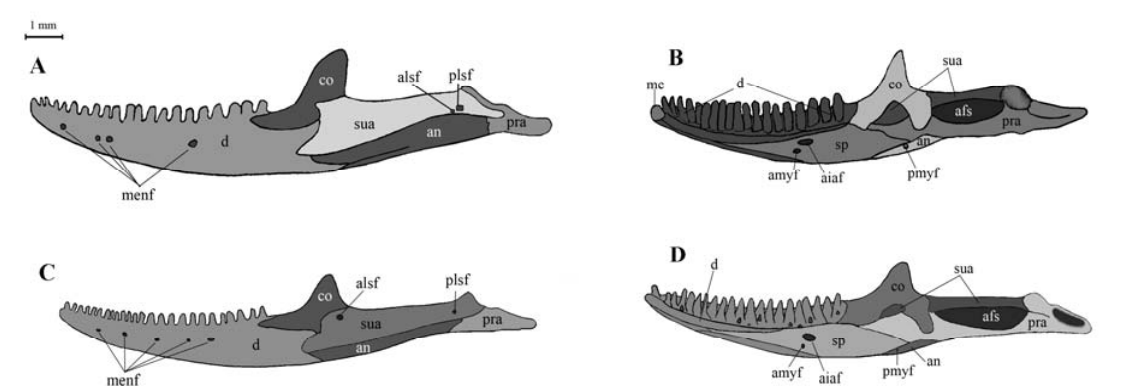
F IGURE 3. Right lower jaw ramus in lateral (A) and medial (B) views in Eremias persica and in Mesalina watsonana, lateral (C) and medial (D) views. Abbreviations: an, angular; afs, adductor fossa; aiaf, anterior inferior alveolar foramen; alsf, anterolateral surangular foramen; amyf, anterior mylohyoid foramen; co, coronoid; d, dentary; mc, Meckel’s cartilage; menf, mental foramina; plsf, posterolateral surangular foramen; pmyf, posterior mylohyoid foramen; pra, prearticular; sp, splenial;